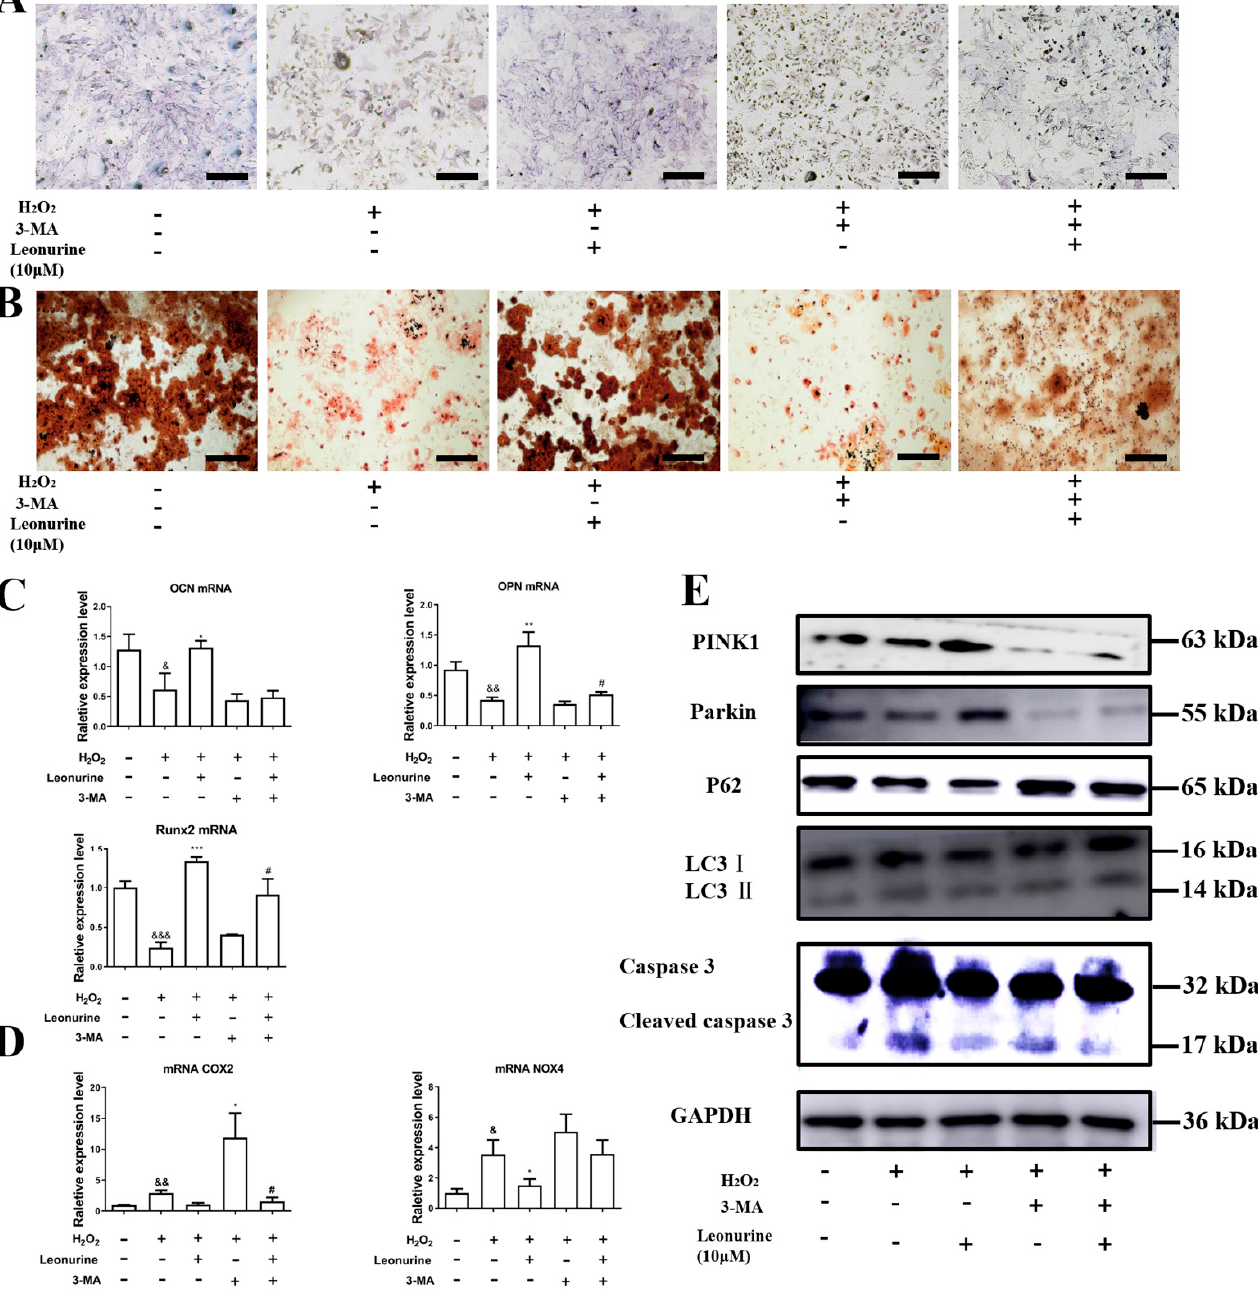
Figure 5. Effects of leonurine on mitophagy-inhibited BMSCs from ROS damage. ( A ) ALP staining on day six (scale bar = 200 μ M). ( B ) Aliza red staining on day 14 (scale bar = 200 μ M). ( C ) Osteogenic- related mRNA expression level. ( D ) Intracellular ROS-related marker expression level. ( E ) Related protein expression change (& p < 0.05, && p < 0.01, &&& p < 0.001 vs. control group. * p < 0.05, ** p < 0.01, *** p < 0.001 vs. H 2 O 2 group. # p < 0.05 vs. 3-MA+H 2 O 2 group).